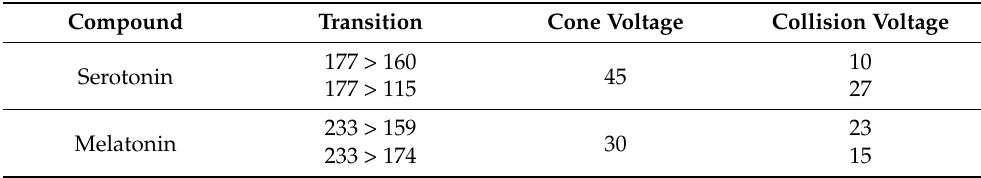
Table 1. Optimized parameters for detection and quantification of neurotransmitters in